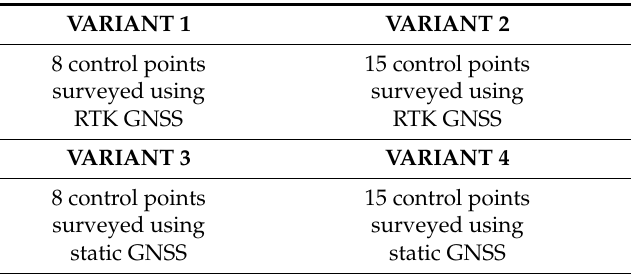
Table 5. Survey data processing